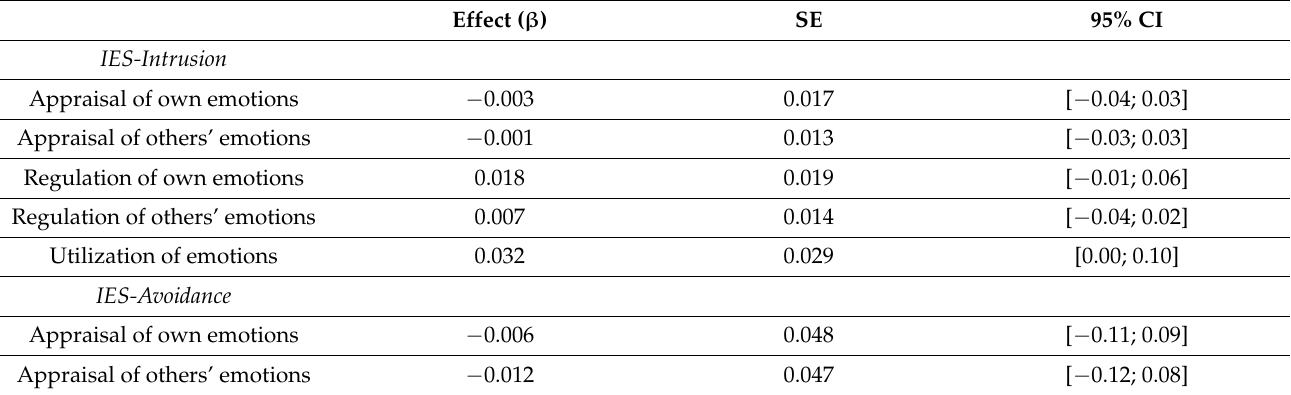
Figure 2. Partial mediation effect of emotional intelligence on the relationship between avoidance and smoking behaviors. Note . ** p < 0.01; * p < 0.05. Table 3. Bootstrapped indirect effects of the association between the impact of cancer, EI, personality traits, and smoking